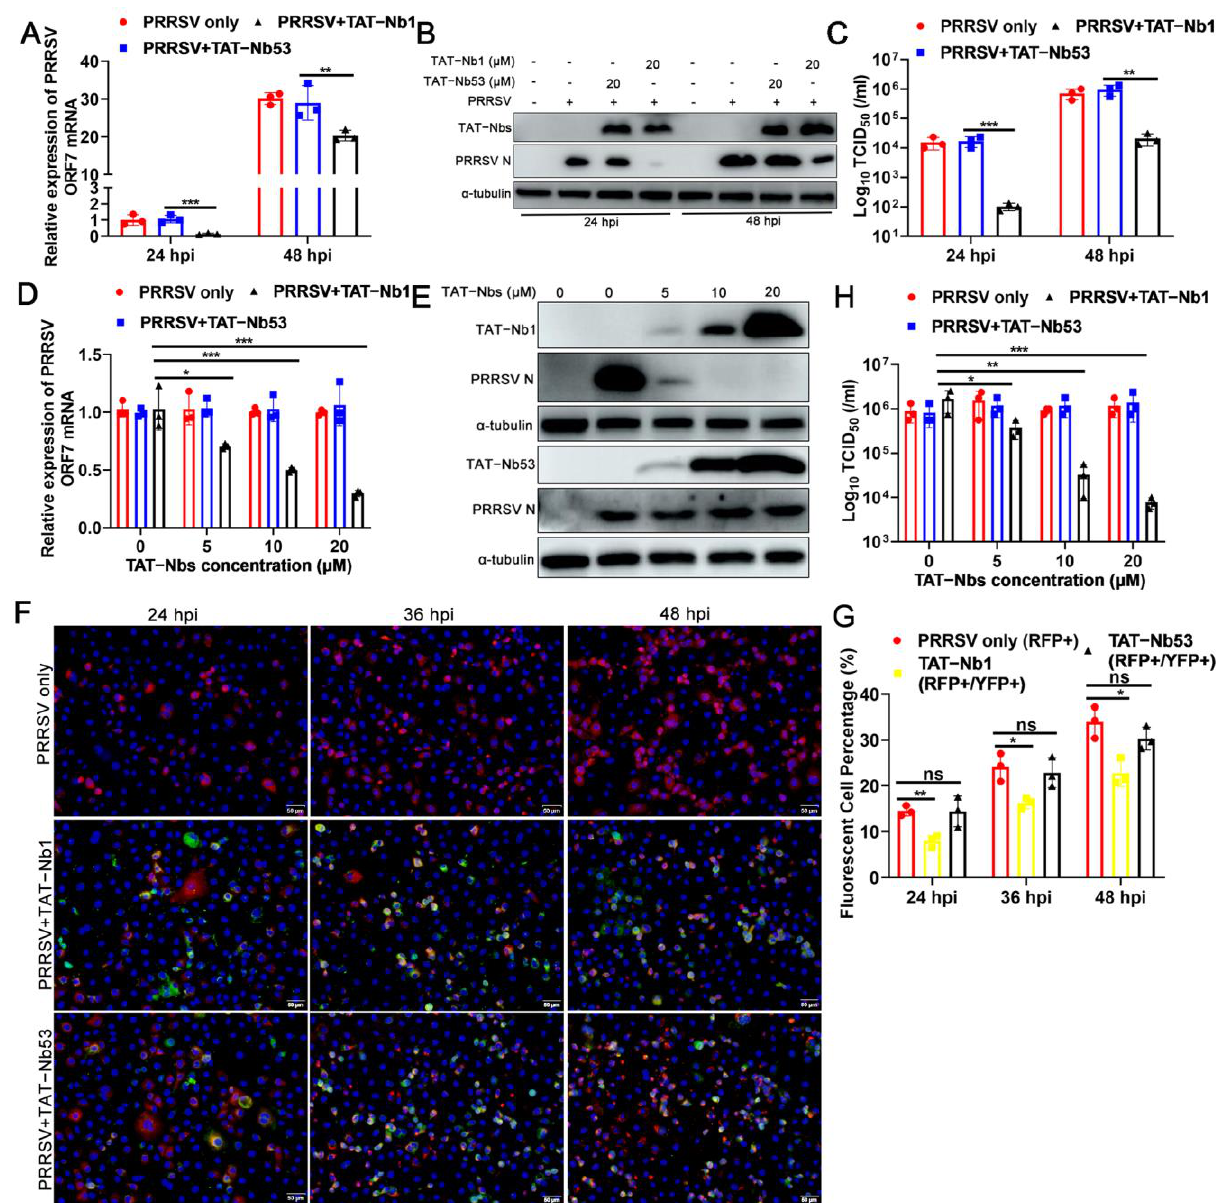
Figure 4. TAT - Nb1 inhibits PRRSV replication in Marc - 145 cells. Marc - 145 cells were seeded in 6 - well plates (2 × 10 5 /well) and incubated overnight at 37 ℃ with 5% CO 2 followed by treating with 20 μM TAT - Nb1 or - Nb53 for 6 h and infected with 0.1 MOI of PRRSV. Cells and supernatants were harvested at 24 and 48 hpi to detect the expression of PRRSV ORF7 mRNA and N protein using qPCR ( A ) and Western blot ( B ), respectively, and supernatant viral titers were analyzed using TCID 50 ( C ). Marc - 145 cells were treated with 0, 5, 10, and 20 μM TAT - Nb1 or - Nb53 for 6 h and then infected with PRRSV (0.1MOI). At 36 hpi, the expression of PRRSV ORF7 and N protein was analyzed using qPCR (D), Western blot ( E ), or IFA ( F , G ), respectively; supernatant viral titers were analyzed using TCID 50 ( H ). α - Tubulin was detected simultaneously as an internal control to normalize the quantitative data. Data are expressed as the means ± standard deviations (SD) of the results of three independent experiments. P values were calculated using Student’s t test or analysis of variance (ANOVA). * , P < 0.05; ** , P < 0.01; *** , P < 0.001; ns, not significant.